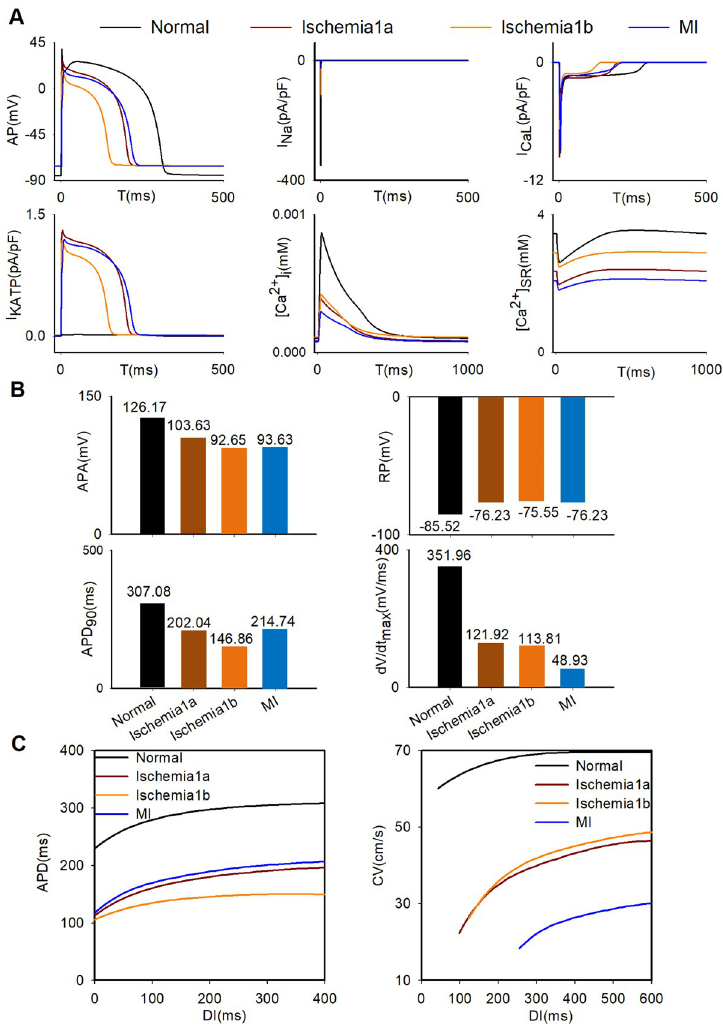
APA, RP, APD 90 and dV/dt max in normal, ischemia1a, ischemia1b, and MI. (C) APD restitution curve using S1-S2 stimulation protocol in a single cell; CV restitution curve using dynamic stimulation protocol in a cable of 600 cells in four different conditions (normal, ischemia 1a, 1b and